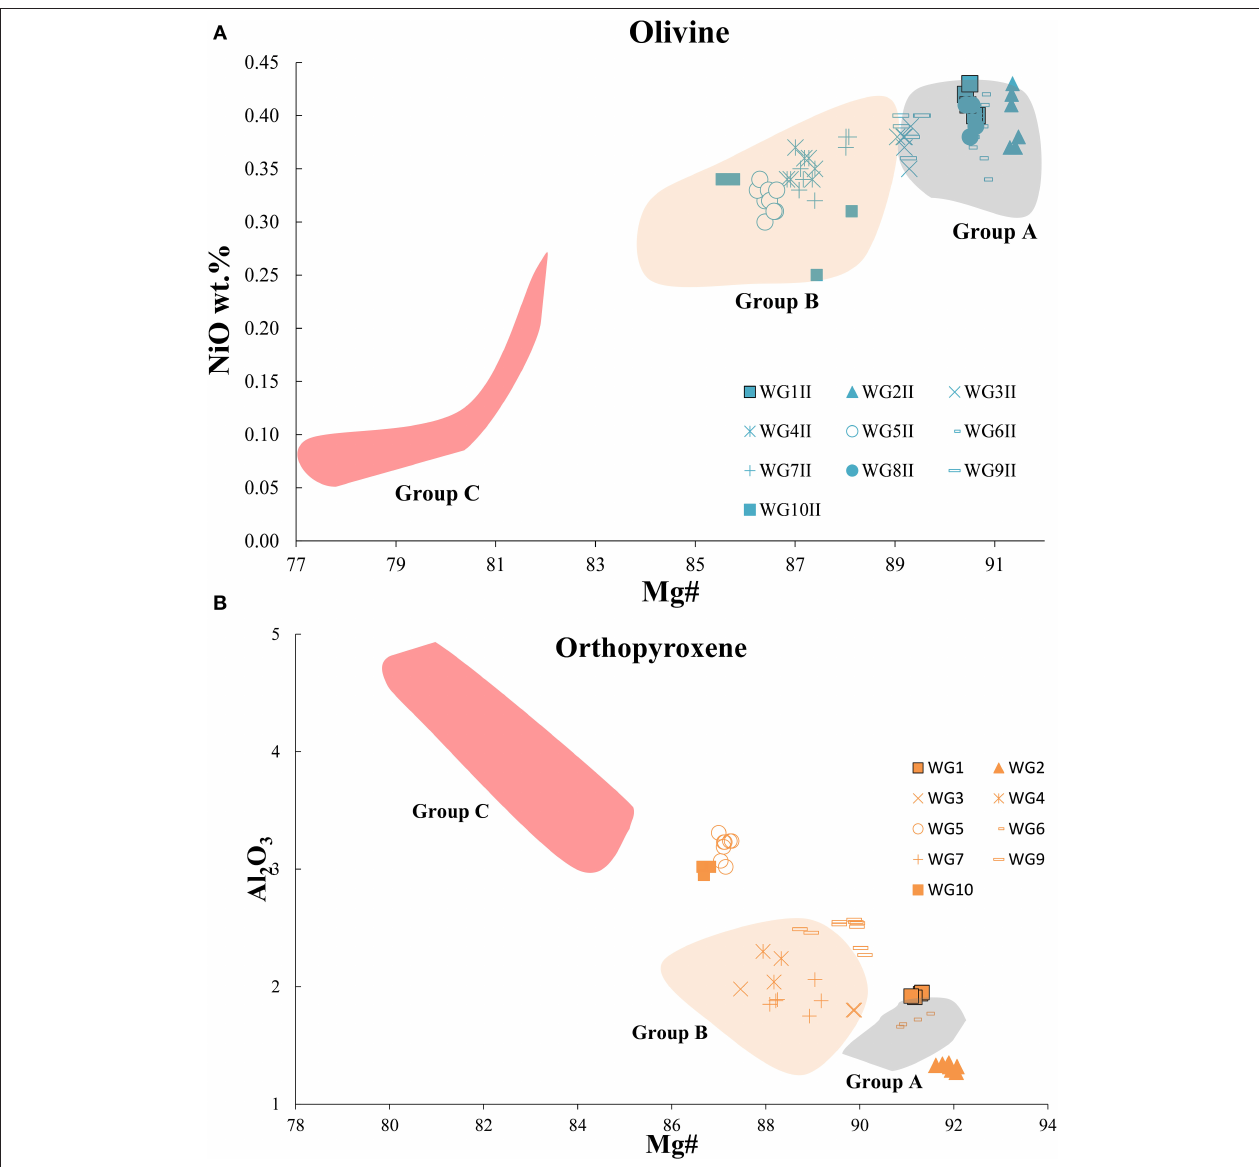
FIGURE 3 | (A) Mg# vs. NiO concentration in Ol. (B) Mg# vs. Al 2 O 3 in Opx from WG xenoliths. The indicated areas are for the group data reported by Matusiak-Małek et al. (2017).